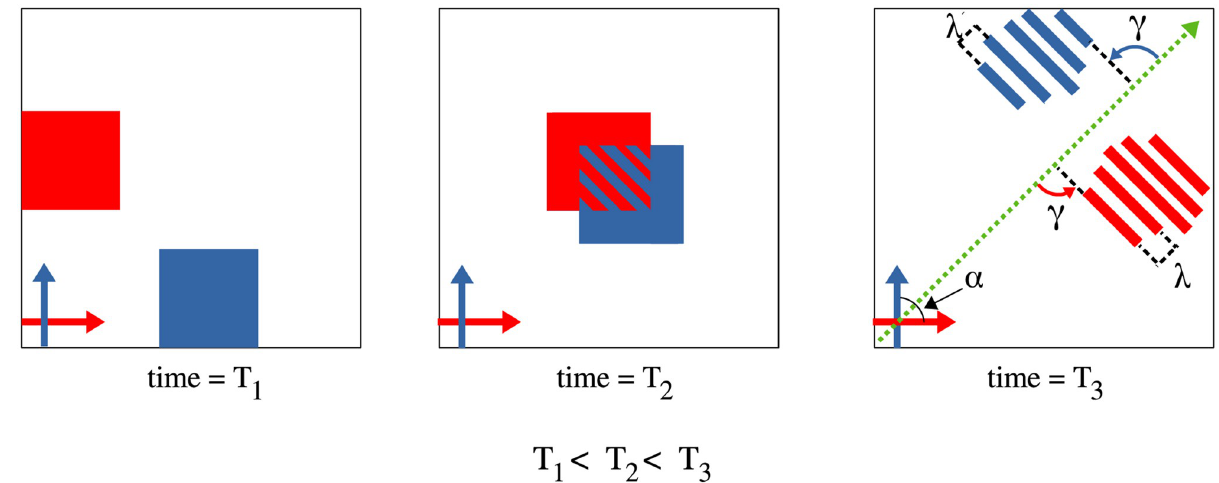
Fig 3. Schematic representation for the formation of stripes and definition of orientation γ and physical separation λ of stripes. Formation of stripes as a consequence of two groups crossing each other. In this schematic diagram the crossing angle between the two groups is α . The figure has been shown for three instances viz. before crossing ( T 1 ), during crossing ( T 2 ) and after crossing ( T 3 ). The two groups before crossing are denoted by blue and red squares, whose direction of motion is denoted by arrows of the same color. The green dotted arrow denotes the bisector of the crossing angle. The orientation γ of the stripes is measured counter-clockwise from the bisector. λ is the spatial separation between two stripes from the same group. For specific definitions of γ and λ see Fig 6.